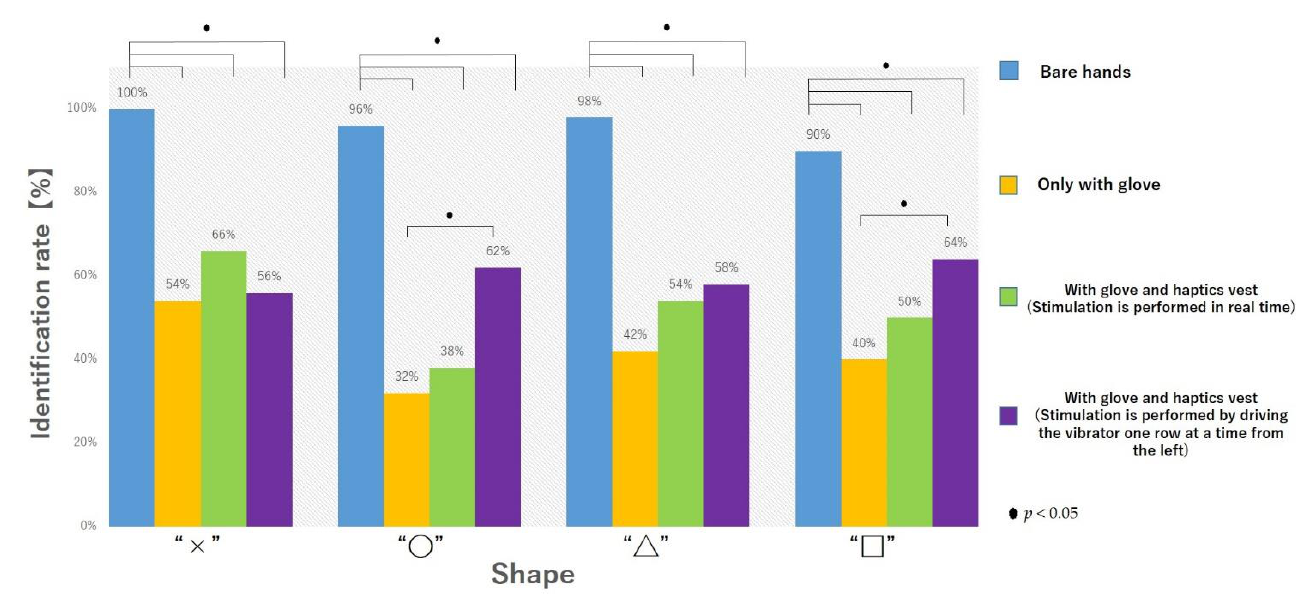
Figure 15. Identification rate of object shape under each scenario.